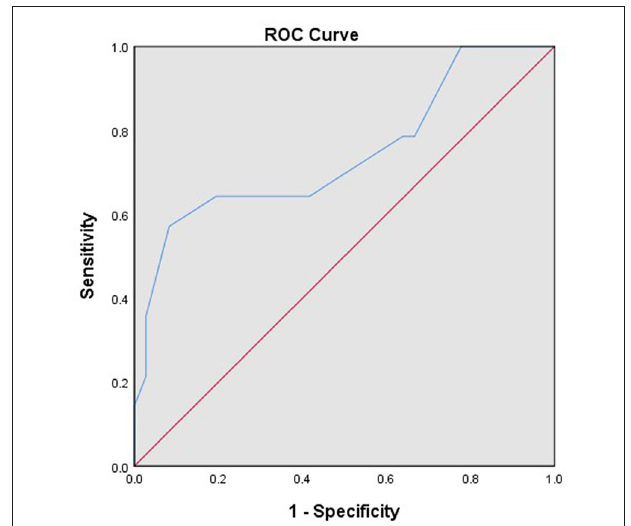
FIGURE 1 | The receiver operating characteristic curve of the Ki-67 index for predicting recurrent endometrial stromal sarcoma.